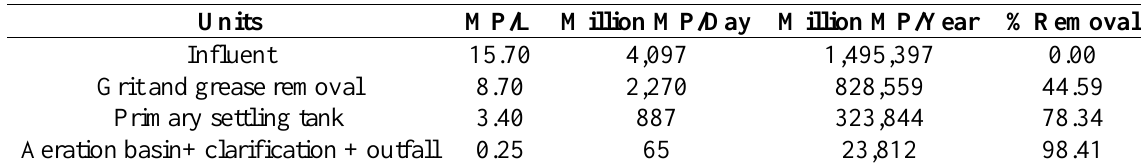
Table 2. MP removal amounts and rates in a wastewater treatment plant [20]